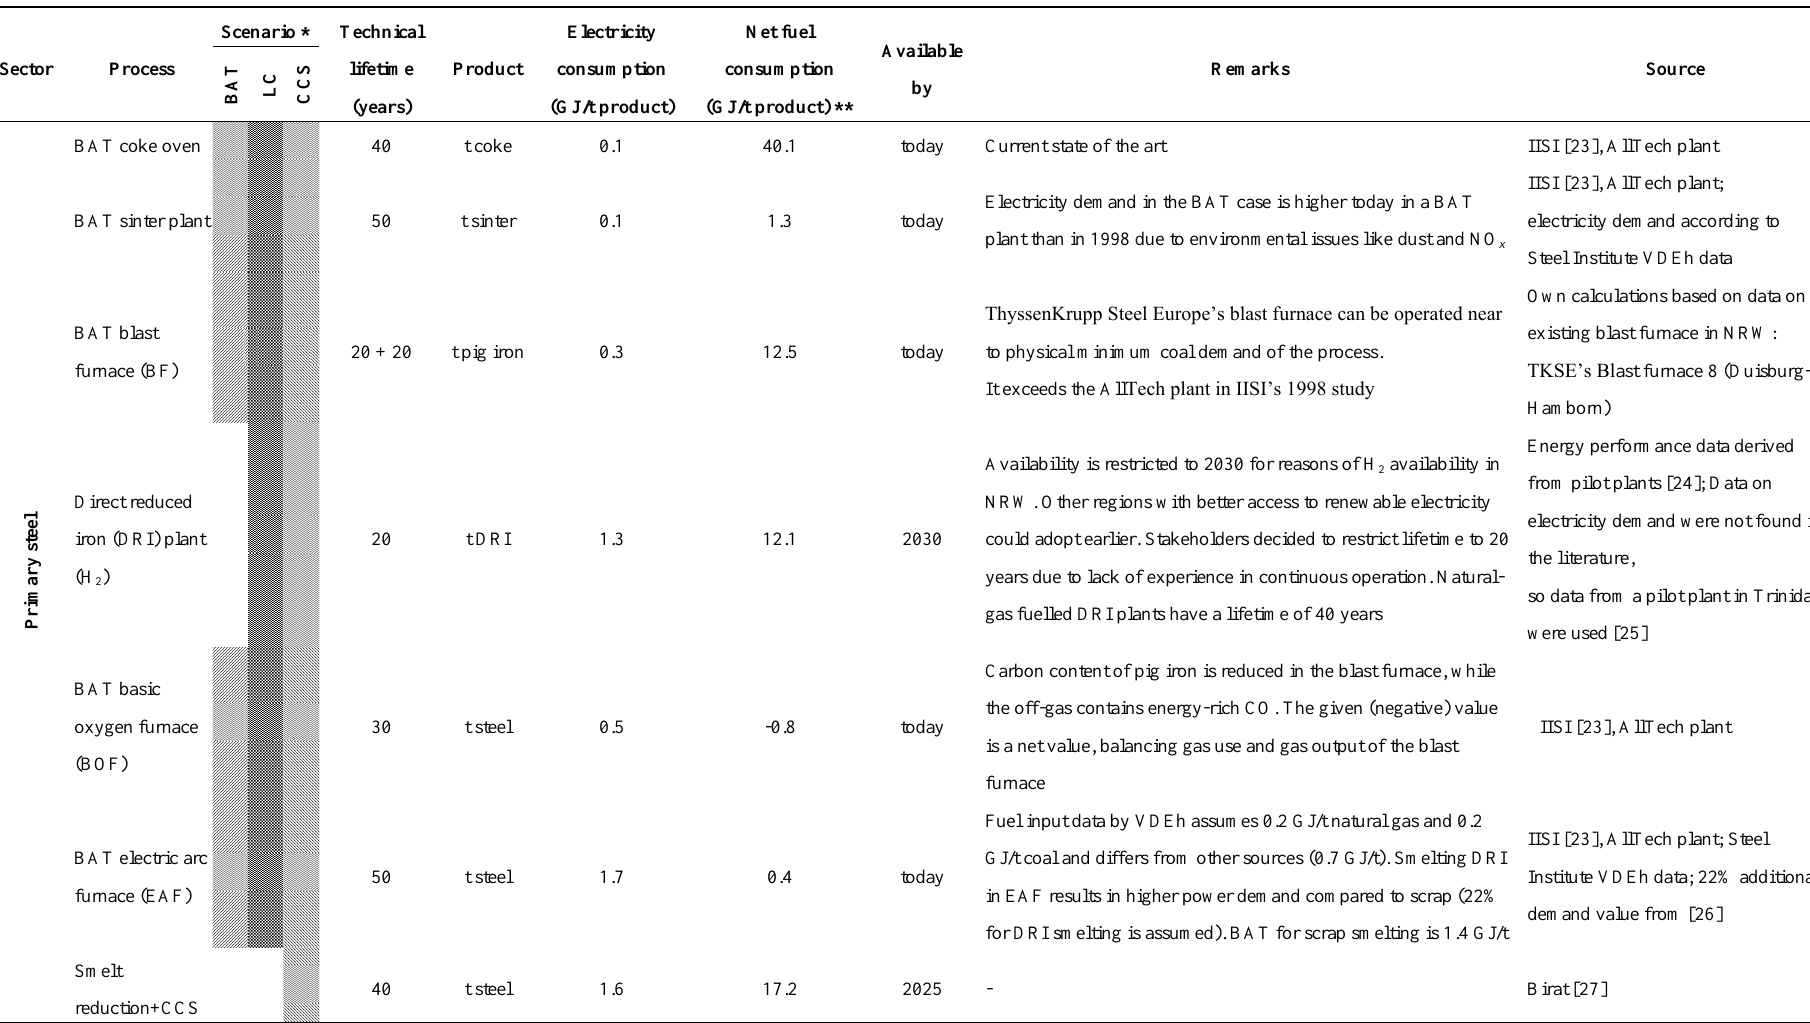
Table 3. Assumptions in the technology matrix approved by stakeholders, and map of scenarios. Sources: compilation of Wuppertal Institute based on stakeholder discussions and literature cited. Shading denotes technologies that were assumed in each scenario. Paper and pulp not included as no stock model was